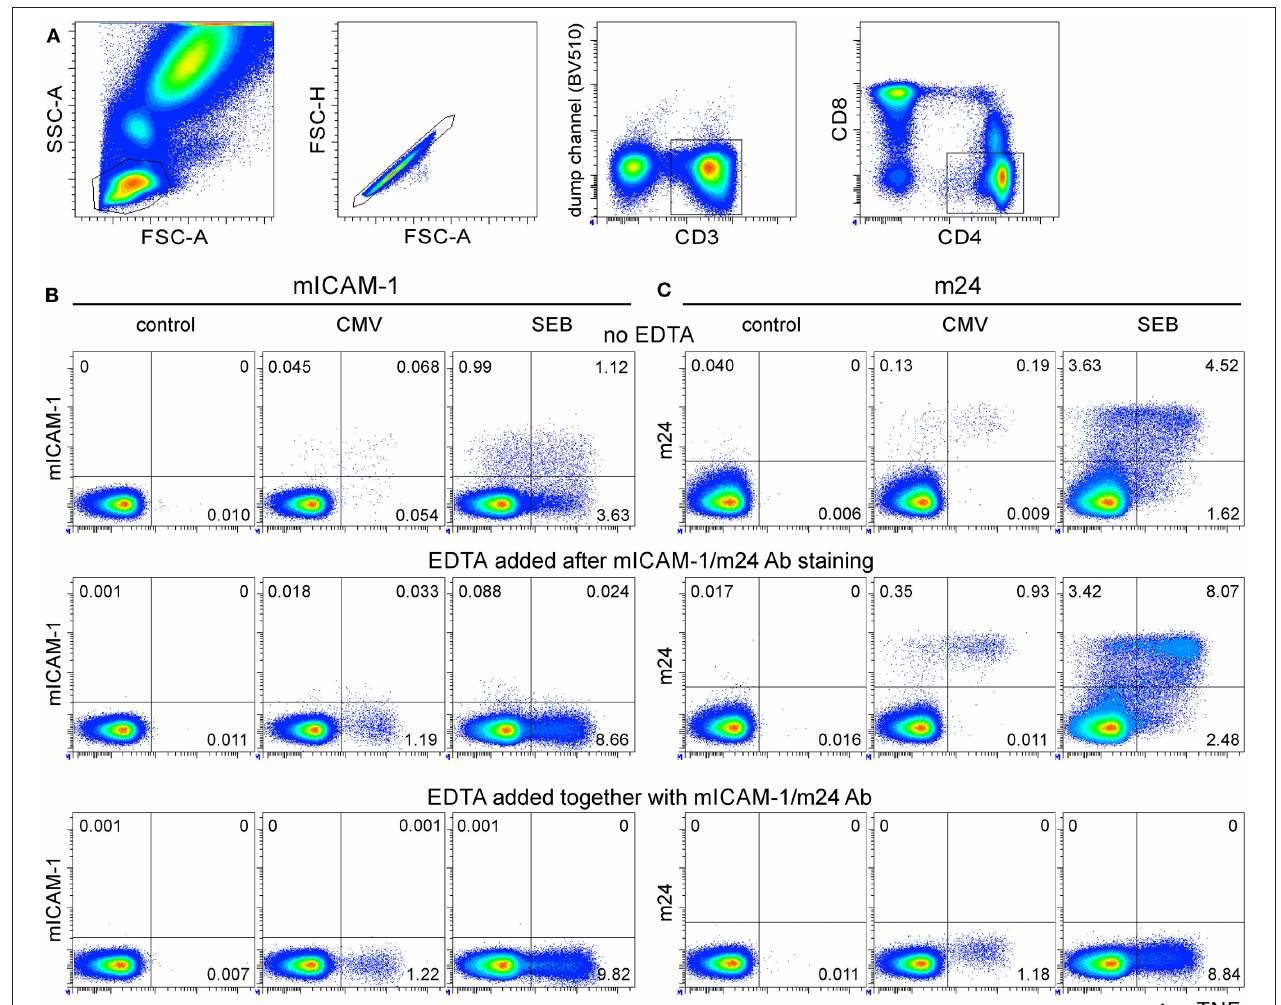
FIGURE 1 | m24 Antibody (Ab) staining of activated β 2 -integrins followed by ethylenediaminetetraacetic acid (EDTA) treatment can be used to detect antigen-specific CD4 + T cells. Assessment of whole blood (WB) antigen-specific CD4 + T cells by staining of activated β 2 -integrins. (A) Gating strategy. From left to right, the lymphocyte gate, the FSC-A/H duplet exclusion, the gating of CD3 + events followed by CD4 + events. (B,C) Intercellular adhesion molecule-1 (ICAM-1) multimer and m24 Ab stainings under different EDTA treatment. WB from a donor having a large number of CMV/HPT-specific CD4 + T cells was cultured without stimulus (left, control), with the CMV/HPT peptide (middle), or with Staphylococcus enterotoxin B (SEB) (right) in the presence of brefeldin A and monensin. After 4h, cells were either stained with multimers of ICAM-1 (mICAM-1) for 4min (B) or with m24 Ab for 15min (C) , without (top), or with EDTA addition after (middle), or at the time (bottom) of the staining. The cells were subsequently labeled with CD3, CD4, and CD8 Abs and for the intracellular expression of tumor necrosis factor (TNF) to identify CMV-specific CD4 + T cells. Numbers indicate frequencies among CD4 + T cells in